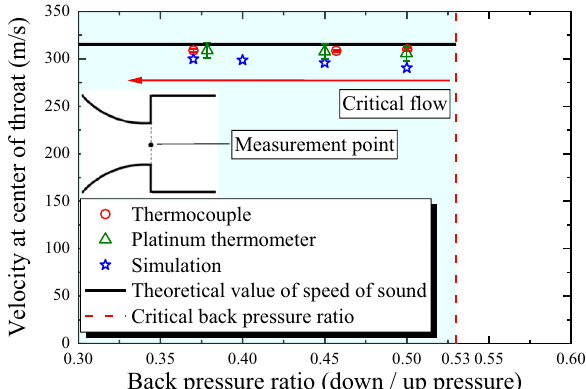
Figure 5. Comparison of RTA and simulation results with theoretical values for flow velocity at the center of the nozzle throat. The experiments were performed three times under the same conditions. The plots show the mean values and the error bars show the standard errors. The critical back pressure ratio of the 90° sonic nozzle is approximately 0.53.